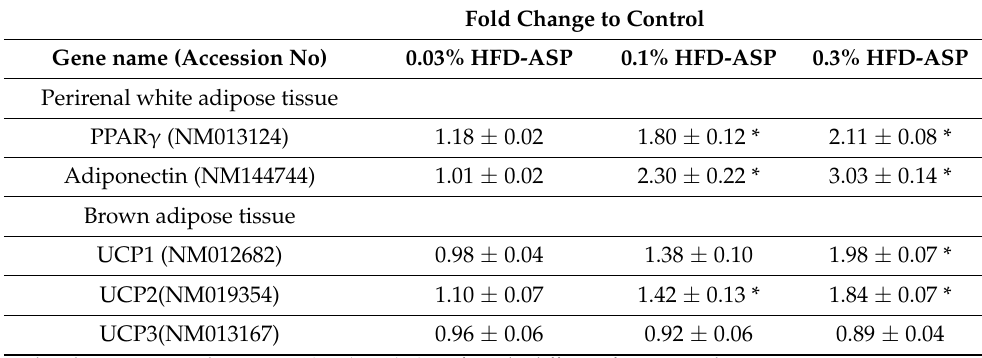
Table 6. Gene expression analysis by real-time PCR in adipose tissue after a three-month administra- tion of ASP in HFD-fed